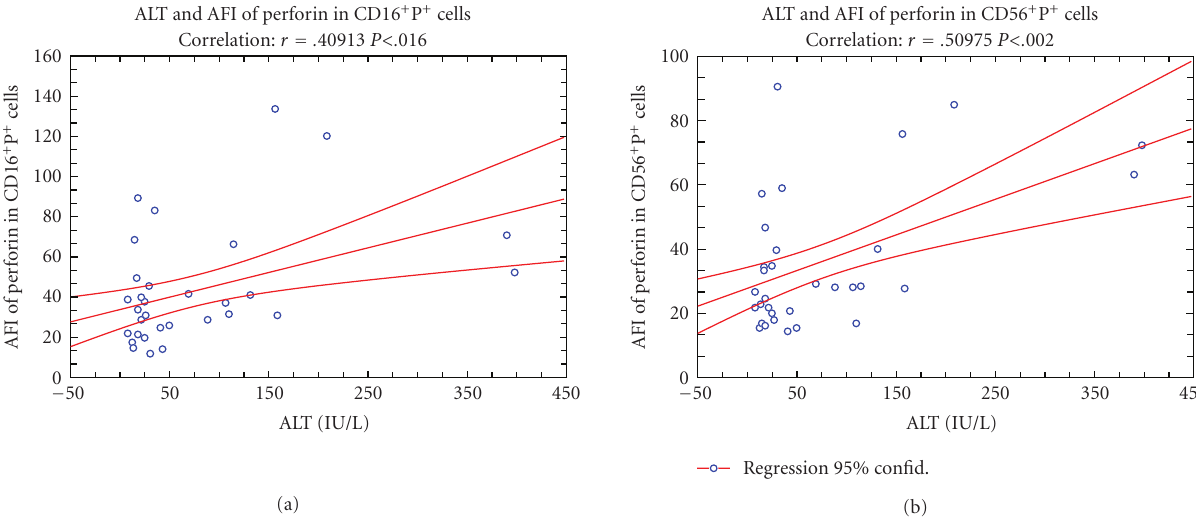
Figure 9: Correlation ( r ) between preoperative serum level of alanine aminotransferase (ALT) and average fluorescence intensity (AFI) of perforin in CD16 + and CD56 + NK